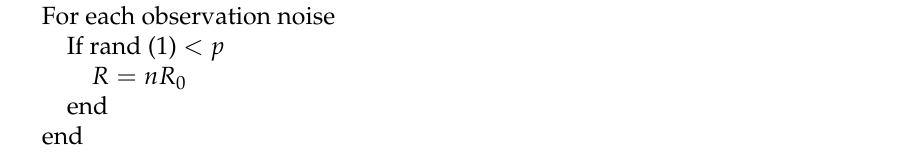
Table 3. Add dynamic observation